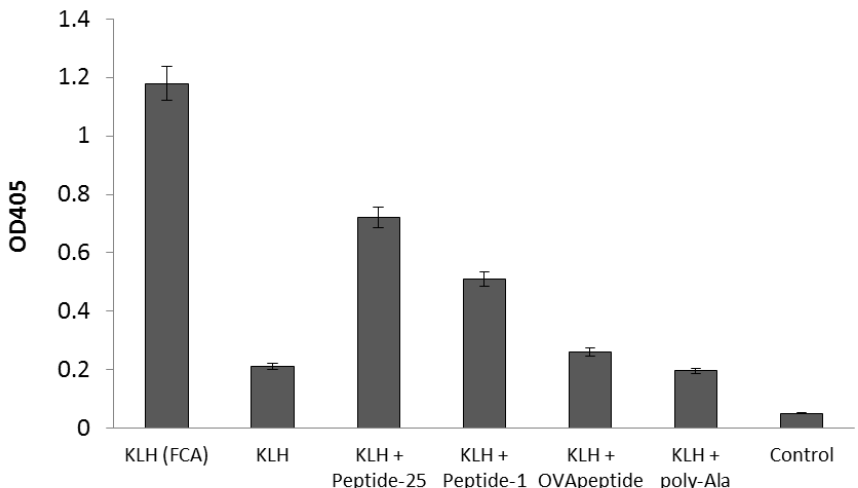
Figure 2. Potentiation of antigen-specific antibody production by agretope peptides. Serum titers (1000 × dilutions) from BALB / c mice immunized intraperitoneally with KLH, in the presence or absence of agretope or control peptides. Peptide-25 denotes a 15-mer peptide derived from Ag85B of M. tuberculosis . Peptide-1 denotes peptide RGIFFYVFAAYKEI, a 14-mer with the highest score from in silico screening. OVApeptide denotes peptide RGISQAVHAAHAEI, corresponding to amino acid residues 323–339 of ovalbumin. Poly-Ala denotes a control peptide composed of 15 alanines. Control denotes serum samples taken before immunization. Columns represent the average of three independent experiments, and error bars represent the standard